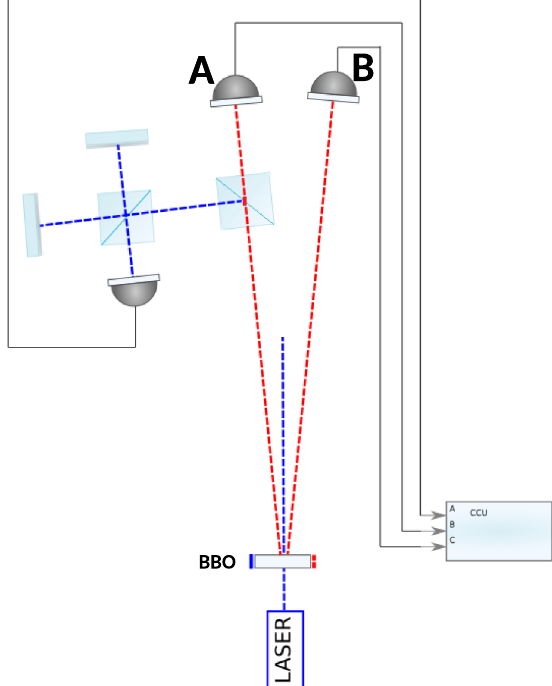
FIG. 2. Schematic setup of the experiment by Grangier et al. [18]. The experiment is based on the principle of heralded pho- tons. If a nonlinear crystal, e.g., beta-barium borate (BBO), is irradiated with intense light from a diode laser, a quantum electrodynamic process called parametric down-conversion sets in as a reaction of this crystal to the incident light [52]. Parametric down-conversion leads to the symmetrical emission of photon pairs due to the conservation of momentum. Two detectors A and B are placed symmetrically facing the crystal. Simultaneous detection events, called coincident events, at the two detectors A and B indicate these photon pairs with high probability. A click at one detector is therefore considered a necessary prerequisite for a single photon at the second detector, or in other words: if detector B clicks simultaneously with A, then B heralds a single photon at A. This can then be experimented